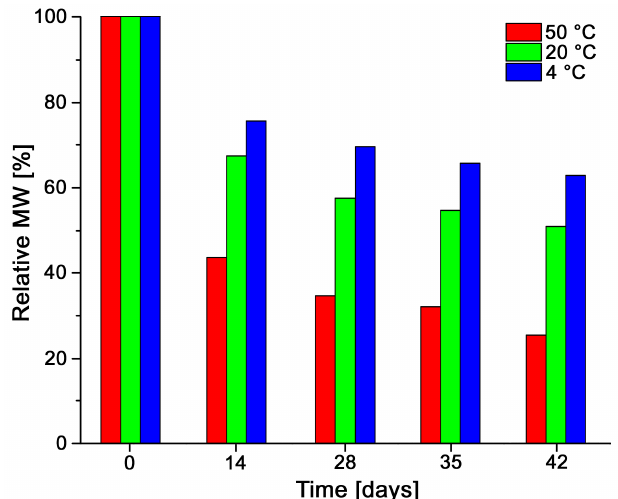
Figure 8. Reduction of the MW of chitosan Q24 at pH 4.5 at 4, 20 and 50 °C.